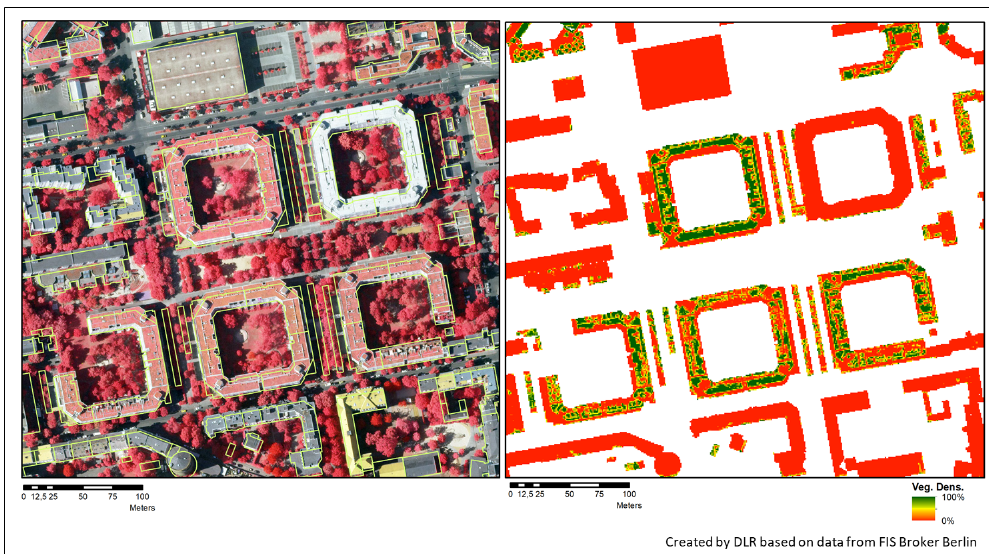
Figure 6. The 10cm CIR image of a small subset of Berlin on the left, overlaid with the building outlines in yellow. The perspective offset between the orthoimage and the building outlines is especially pronounced for the high round building at the bottom. The resulting vegetation density map for PALM at 1m resolution is shown in the right illustration. Sources: FIS Broker (dl-de/by-2-0: https://www.govdata.de/dl-de/ by-2-0, last access: 26 October 2020) CIR Luftbilder.